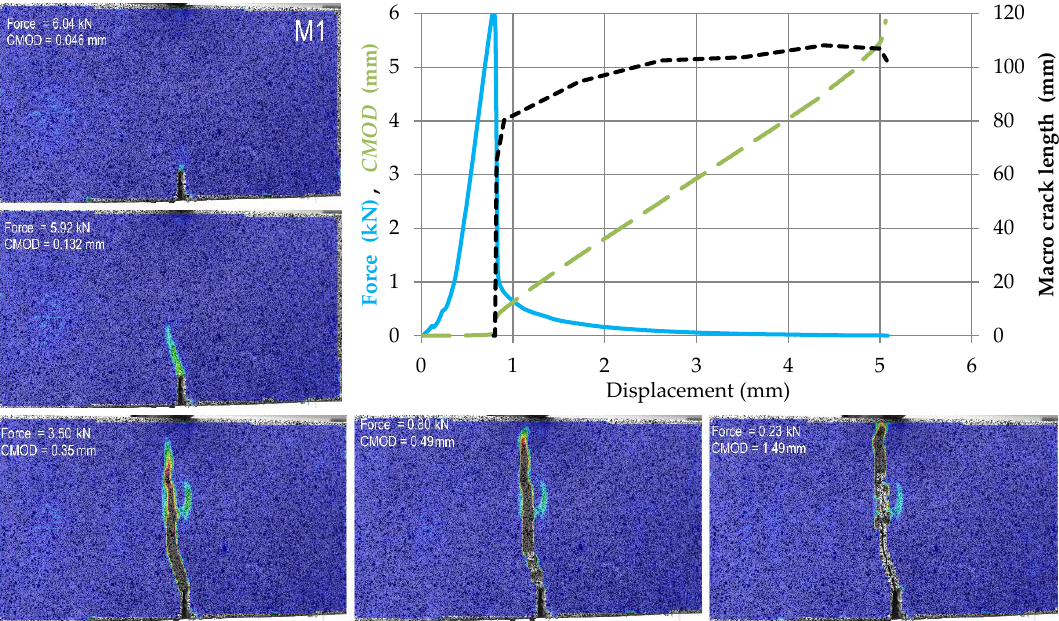
Figure 10. Force, CMOD and summary macro-crack length as a function of displacement in case of material M1 accompanied by cracks development in five chosen stages (contour plots of equivalent Huber–Mises strains).